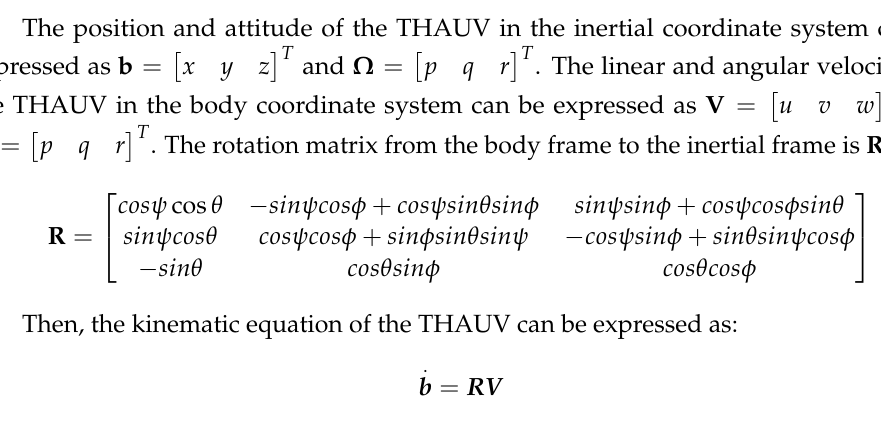
Figure 4. Coordinate system of the THAUV.